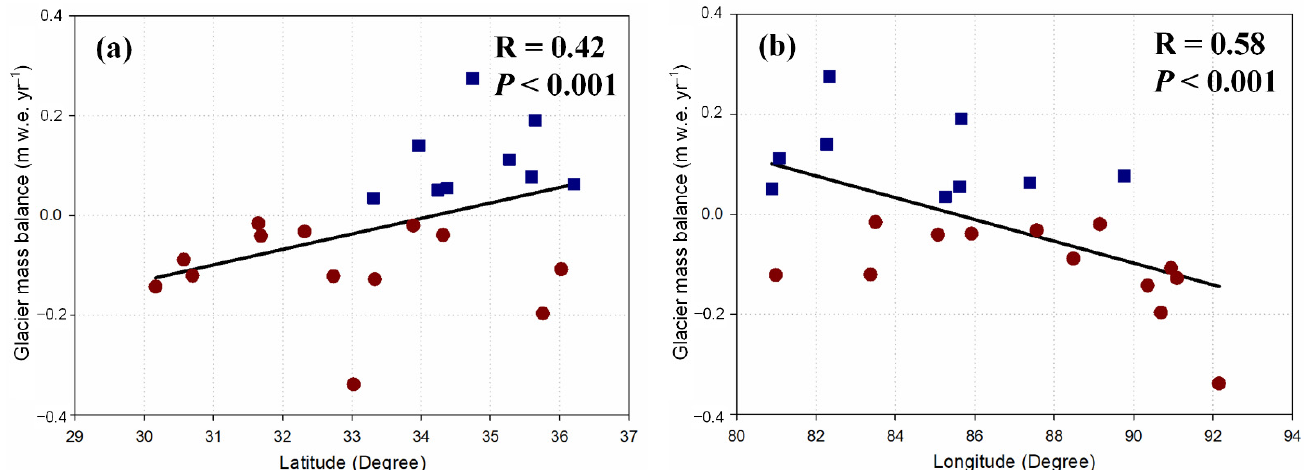
Figure 9. The correlation between glacier mass change and latitude ( a ) and longitude ( b ) for these 22 study sites in the INTP. The study site experienced a glacier mass gain from 2000 to 2012, which is indicated as a blue rectangle. The dark red circles represent the study sites with a negative glacier mass change during the studied period.